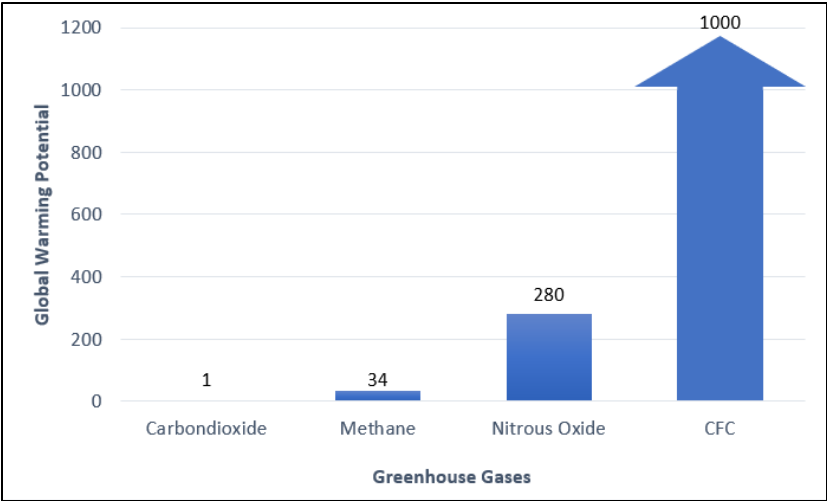
Figure 1. Global Warming Potential (GWP) of various types of greenhouse gases [1].